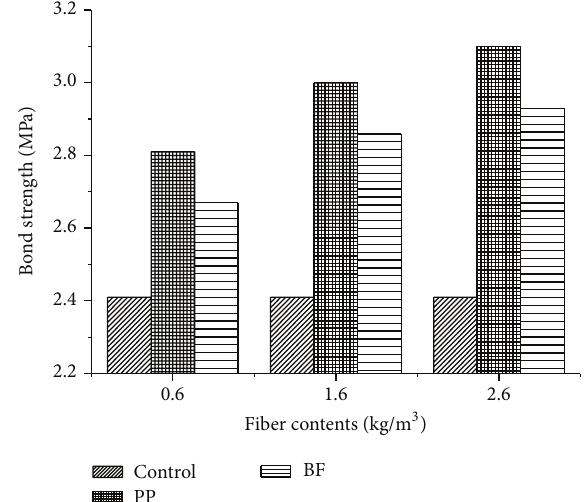
Figure 5: Bond strength between FRM and the old mortar.